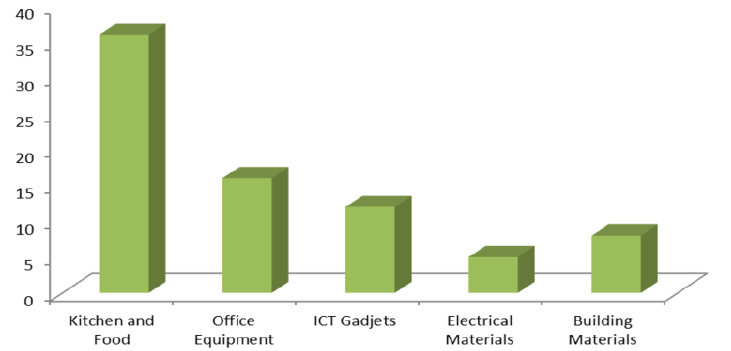
Figure 4: Comparison of looted materials from